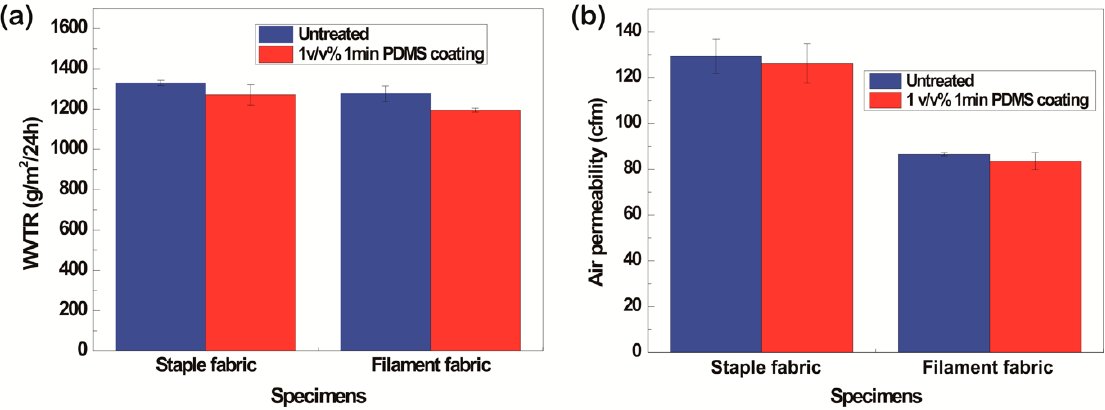
Figure 9. WVTR (a) and air permeability (b) of untreated and P1T1 PDMS-coated staple fabrics and filament fabrics.